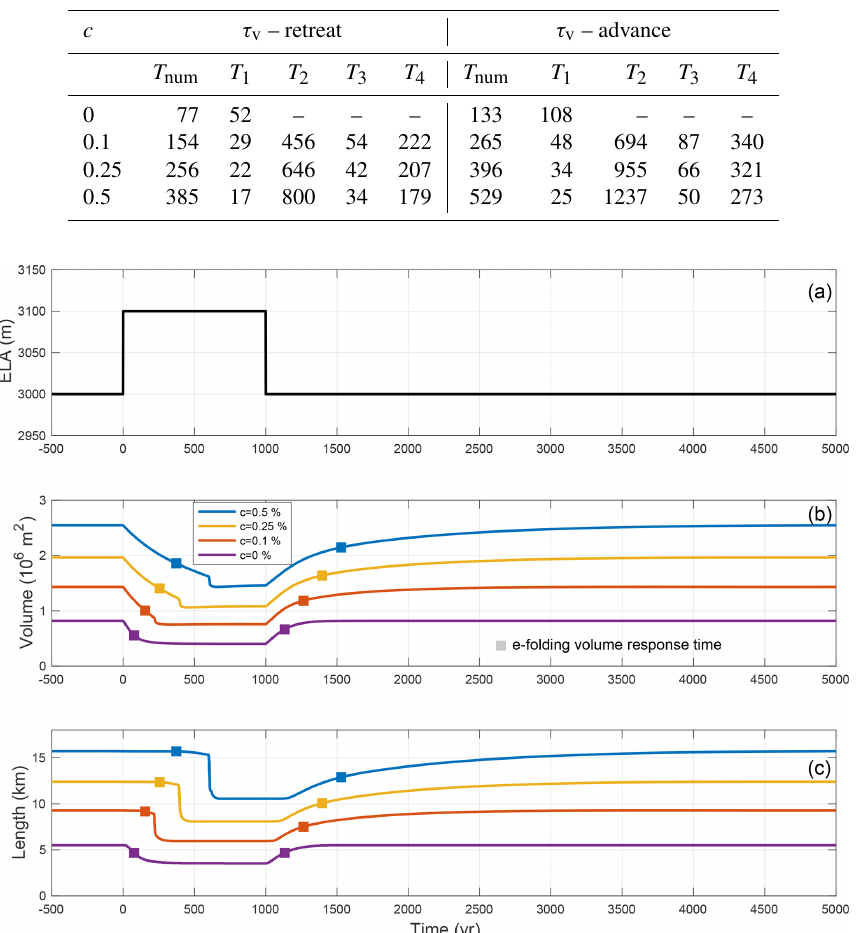
Table 3. Comparison of numerical e -folding volume response times (in years) due to step changes between steady states at ELA = 3000 and ELA = 3100m for different debris concentrations. The columns marked T num represent the numerical volume response time, and the other columns represent the theoretical estimate of Jóhannesson et al. (1989) developed for clean ice using different methods of calculating the surface mass balance at the terminus (see Sect. 4.4 for details).